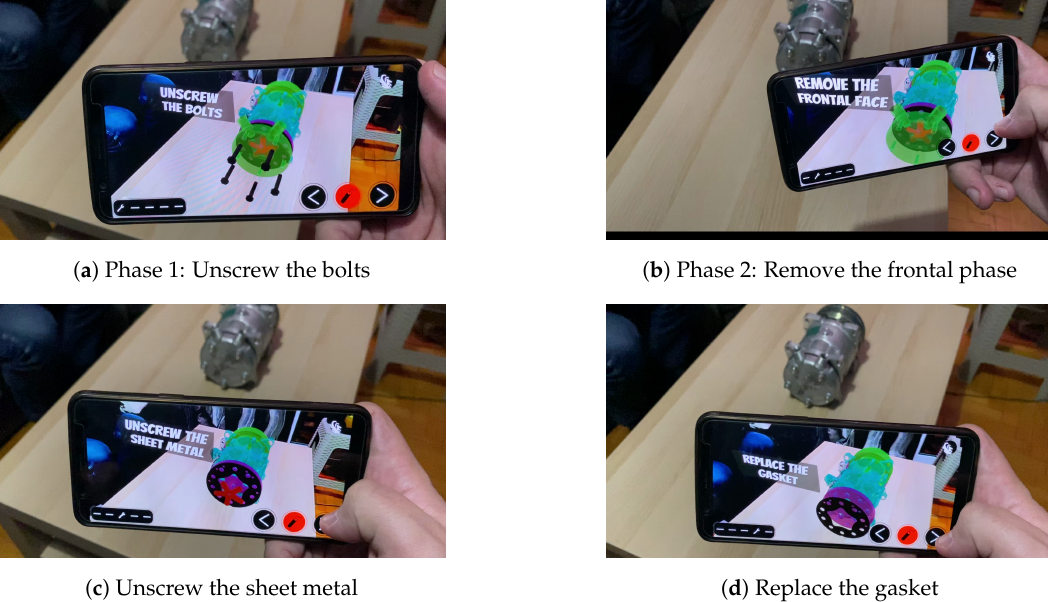
Figure 7. Demonstration of the maintenance steps of an A/C compressor using MARMA in a mobile